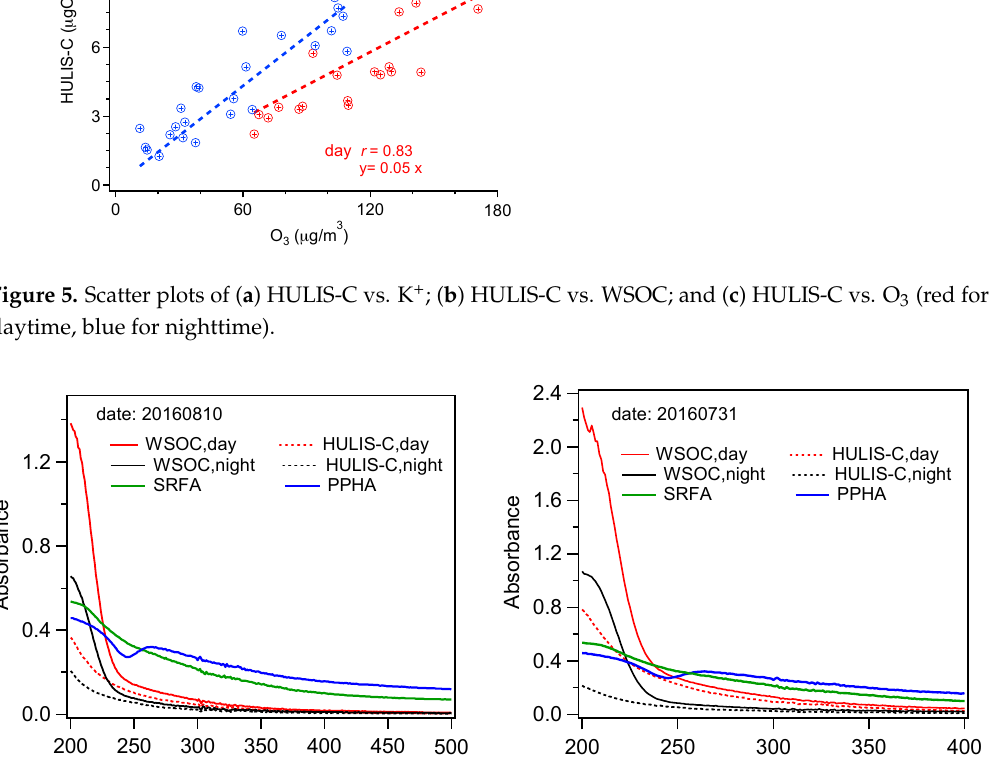
Figure 7. Temporal variation of E 250 /E 365 of HULIS-C (hollow triangles) and WSOC (hollow circles) for daytime (top panel) and nighttime samples (bottom panel). 3.4. Determination and Sources of WSON and WSTN As discussed in earlier studies [23,54], the determination of WSON concentrations by subtracting WSIN from WSTN in some cases yields negative values due to measurement uncertainties and night